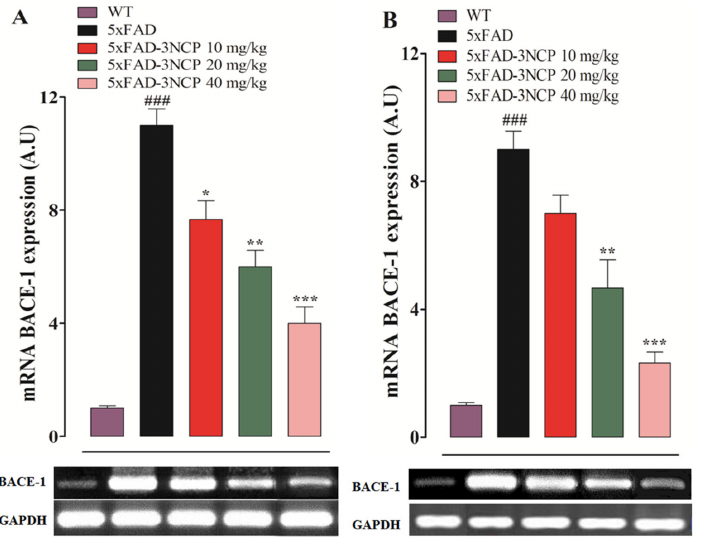
Figure 8. Effect of the 3NCP on the mRNA expression of BACE ‐ 1 in the hippocampus ( A ) and frontal cortex ( B ) was measured. The results were obtained using ImageJ software and expressed in an arbitrary unit (A.U). * p < 0.05, ** p < 0.01, *** p < 0.001 compared to the 5xFAD ‐ mice and ### p < 0.001 compared to the WT ‐ mice.